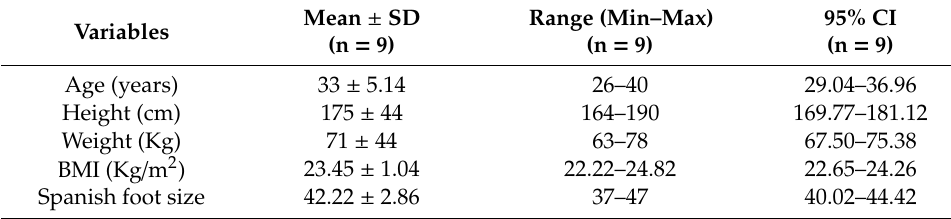
Table 1. Anthropometric and demographic characteristics of the sample of